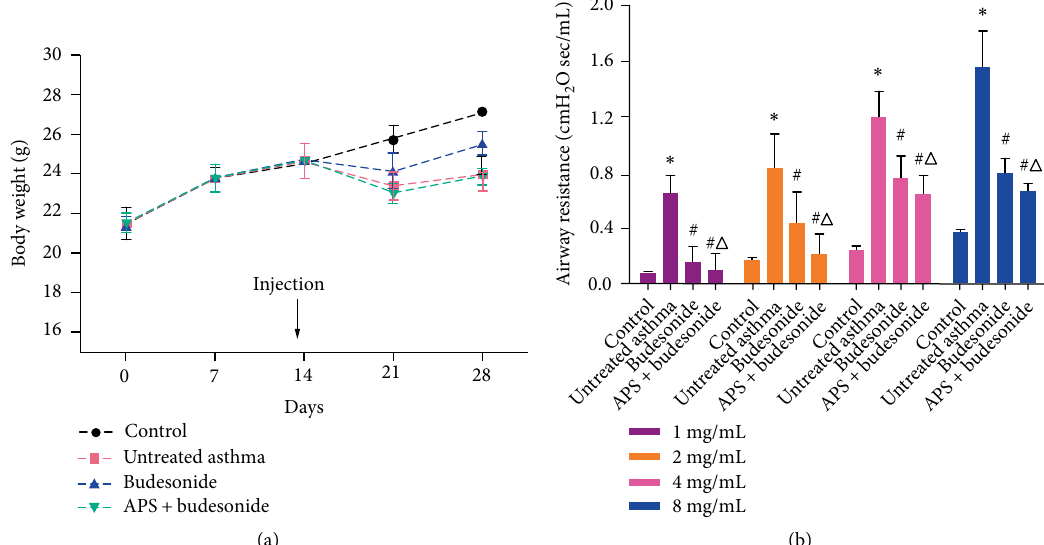
Figure 1: Body weight and airway resistance effected by APS and budesonide treatment. (a) The body weight change of mice in 4 groups ( n = 8 per group) was monitored within 28 days. (b) Airway resistance in mice was measured after treatment. Mean ± SD is presented for each group. 𝑃 < 0.01 , compared with control group; # 𝑃 < 0.05 , compared with untreated asthma group; ∗ frequency of DCs in APS + budesonide group was significantly lower than that in budesonide group ( 𝑃 < 0.05 ; Figure 2).